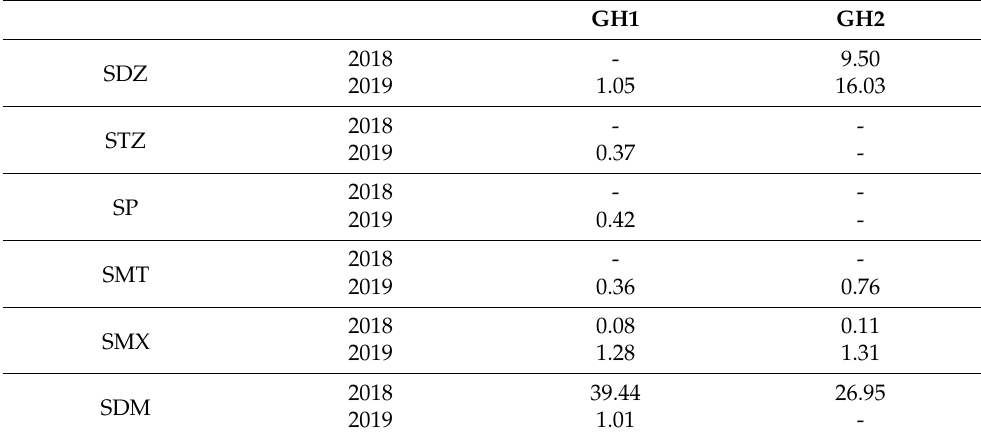
Table 6. Translocation factors of sulfonamides (sulfadiazine (SDZ), sulfathiazole (STZ), sulfapyridine (SP), sulfamethizole (SMT), sulfamethoxazole (SMX) and sulfadimethoxine (SDM)) in the tomato plants from two commercial greenhouses in 2018 and 2019.